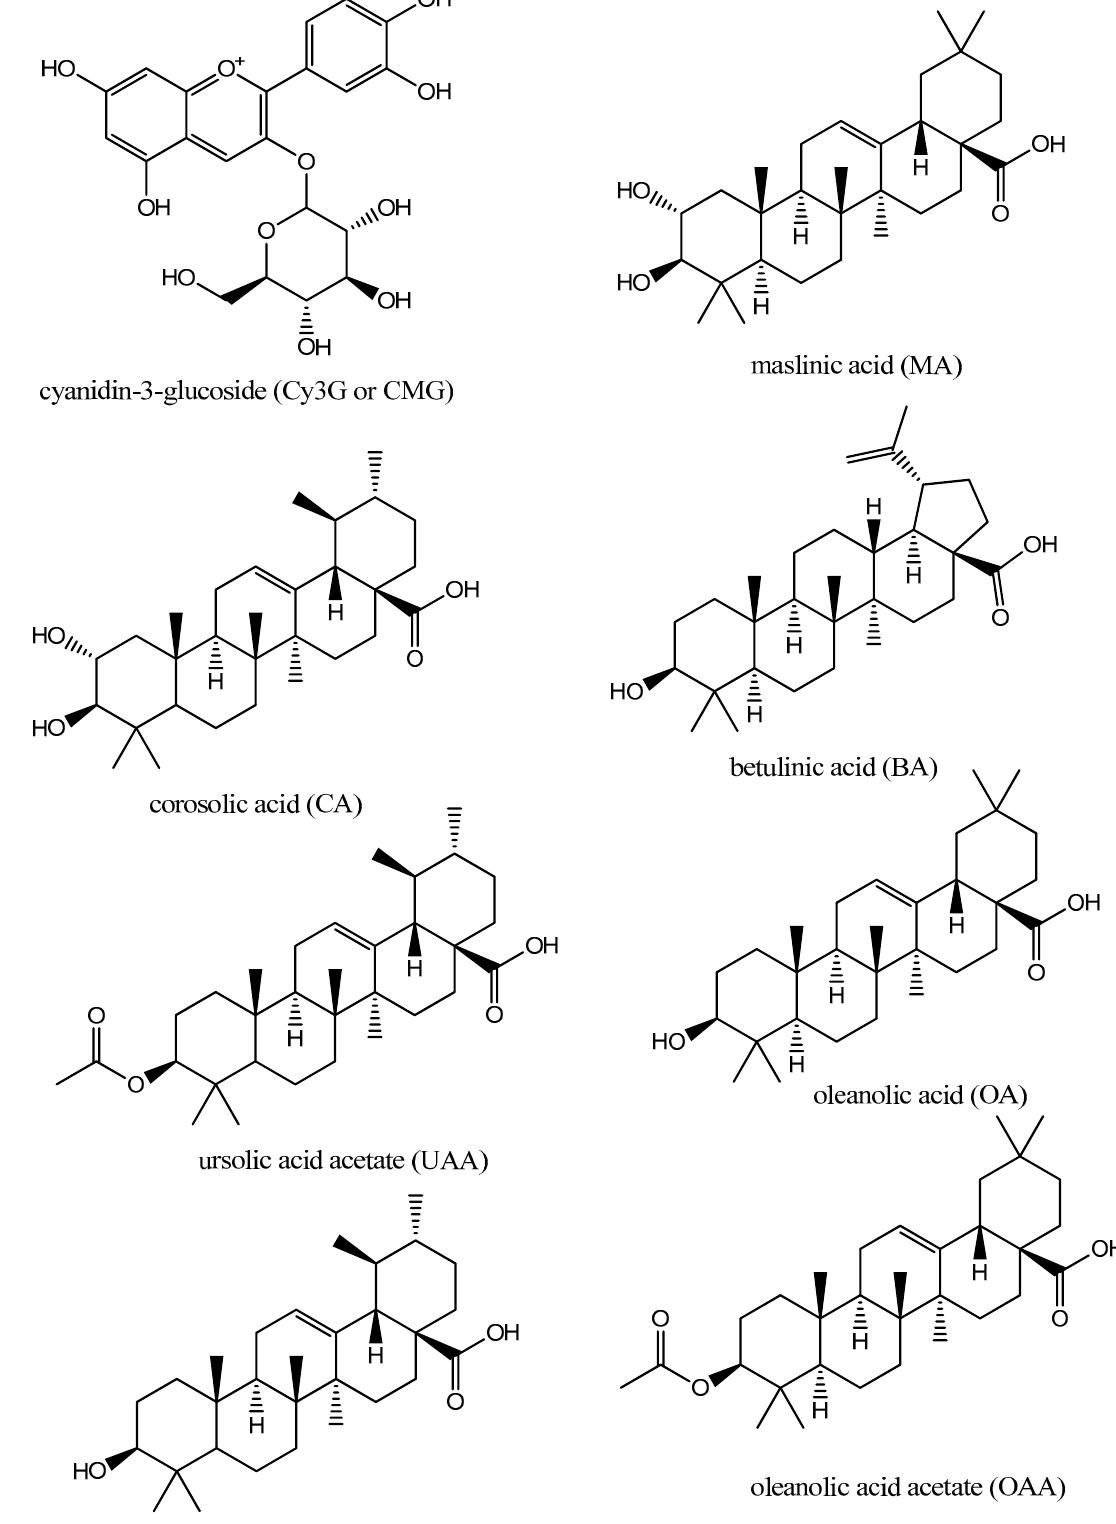
Figure 1. Chemical structures of CMG, MA, CA, BA, UAA, OA, UA, and OAA. Furthermore, CA has been reported to decrease blood sugar levels, and exhibits an- tihyperlipidemic, antiviral, and osteoblastic activities [15]. Pavlova et al. reported BA to